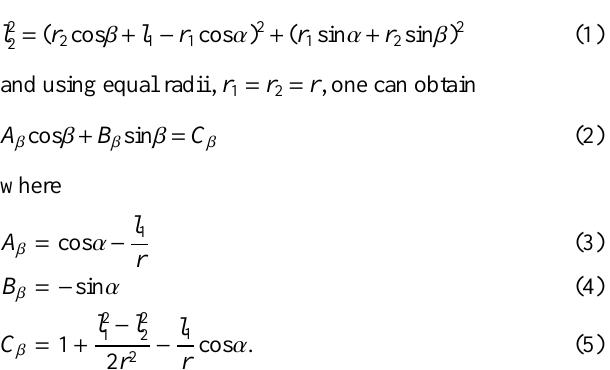
Figure 2. Linkage connecting the metacarpals.